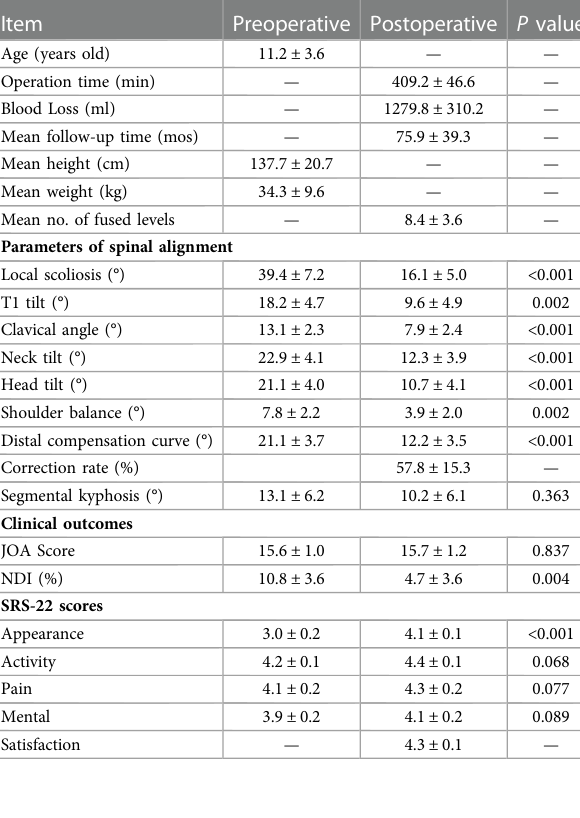
Feil syndrome. Treatment strategy: This type of cervical hemivertebra could be treated conservatively with regular observation because there is no obvious appearance deformity ( Figure 6 ).